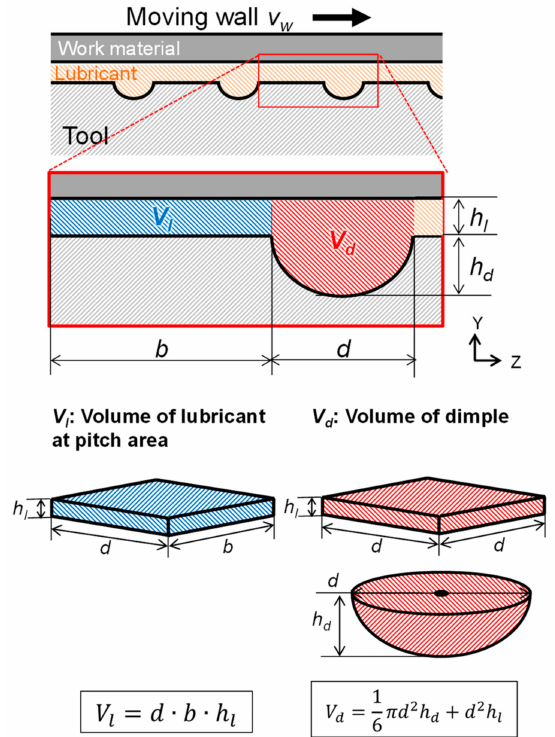
Figure 12. Schematic illustration for geometrical calculations of the relative volume of lubricant flow into the dimple cell V l and the volume of dimple cell structure V d .